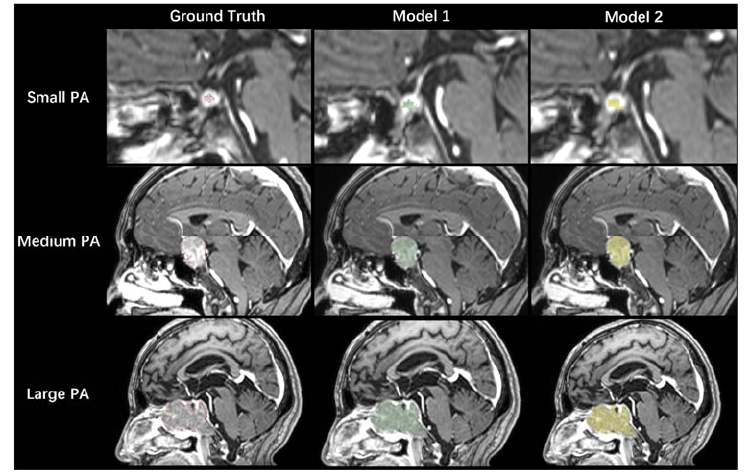
Figure 4. Performances of the models in different PA groups with different volumes in the testing dataset.